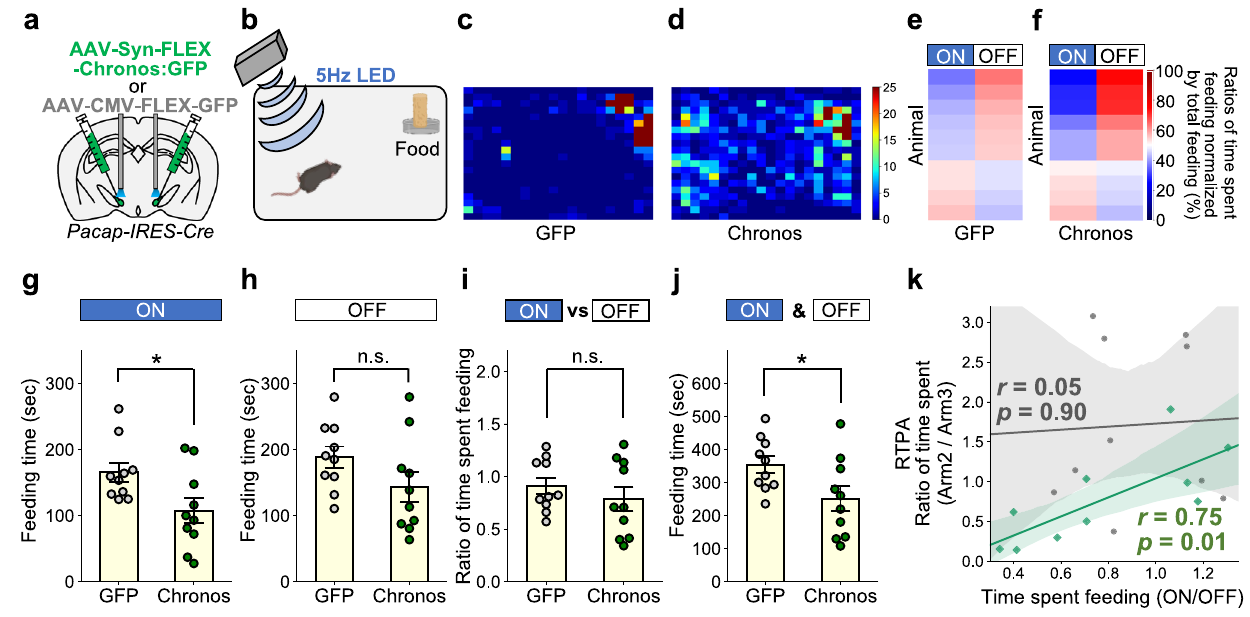
Fig.8|FeedingbehaviorissuppressedbyactivationofthePACAP PSTN neurons. a Bilateral injection into Pacap-IRES-Cre mice. b Schematic illustration of the feeding test. c , d Each heatmap represents the time spent in each area for a representative mouse during the 12-min observation period. e , f Heatmaps repre- sentratiosoftimespentfeedingduringLED-on(6min)andLED-off(6min)tototal feeding time for each individual mouse. g Time spent feeding during a 6-min LED- on period. h Time spent feeding during6-minLED-offperiod. i Ratiooftime spent feeding during LED-on/LED-off periods. j Total time spent feeding during the 12- minobservationperiod.Eachcirclerepresentsresultsfromonemouse(GFP, n =10;